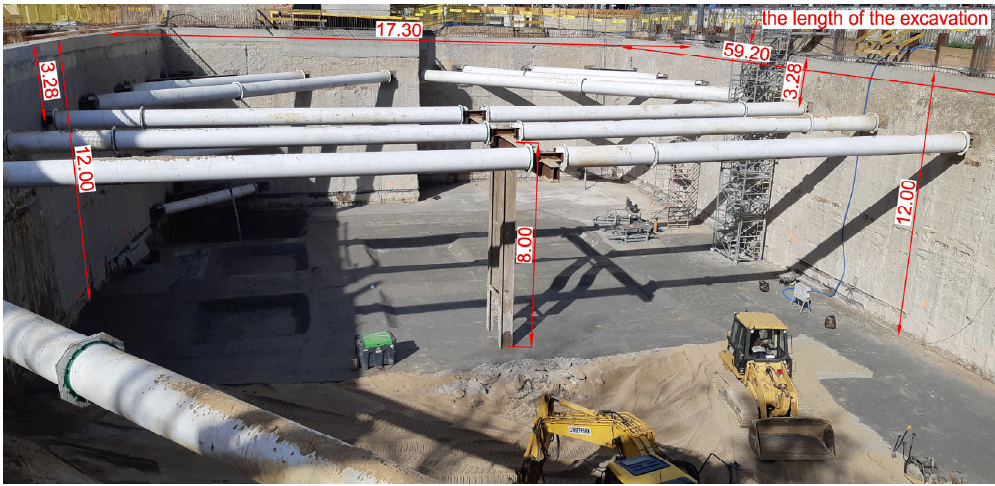
Figure 3. Protection of deep excavation by means of diaphragm wall and struts system.